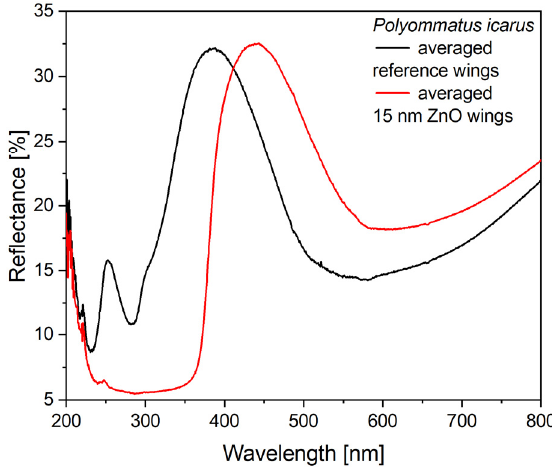
Figure 6. The effect of the deposited 15 nm thick ZnO layer onto the wings of P. icarus males.